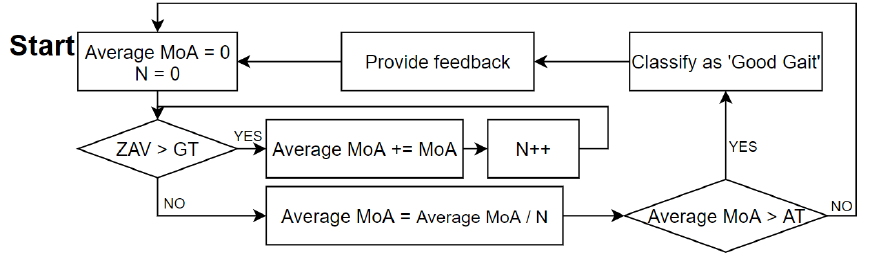
Figure 3. Flowchart explaining the algorithm process.